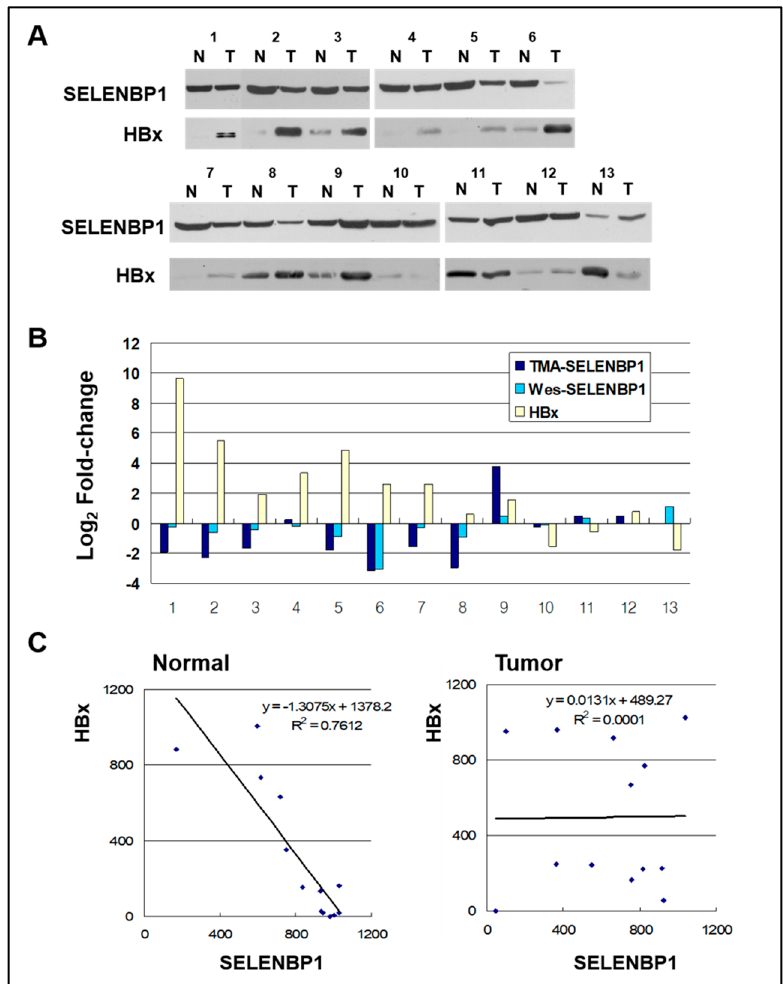
Figure 4. SELENBP1 and HBx in normal and HCCs. ( A ) Sixty micrograms of total protein from normal (N) and tumor (T) liver tissues of HCC patients with hepatitis B virus (HBV) were separated by SDS-PAGE and transferred to a membrane. The membranes were probed using anti-SELENBP1 and anti-HBx. ( B ) Comparison of changes in SELENBP1 protein expression level as measured by TMA and Western blot. Fold changes in HBx protein expression measured by Western blots are also shown. Values are expressed in fold change (Log 2 ) compared to normal tissues. ( C ) Relationship between SELENBP1 and HBx protein levels as determined by linear regression analysis in normal and tumor tissues. A significant strong correlation was observed between SELENBP1 and HBx expression in normal tissues, and no correlation in tumor tissues. Regression equations and lines are shown in the graph.